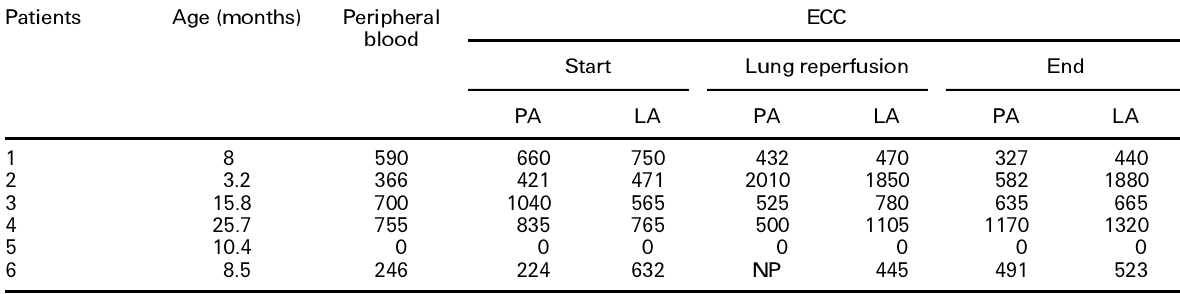
Table 2. LTE 4 levels (pg / ml) detected in blood samples obtained from infants (Fallot) Patients Age (months)